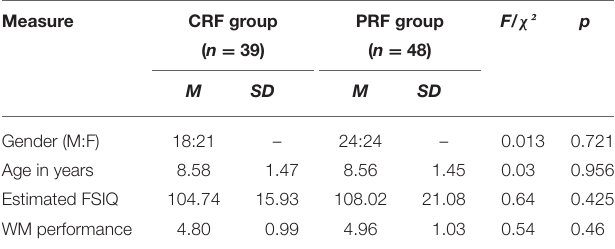
TABLE 1 | Means and standard deviations of group demographics and characteristics.